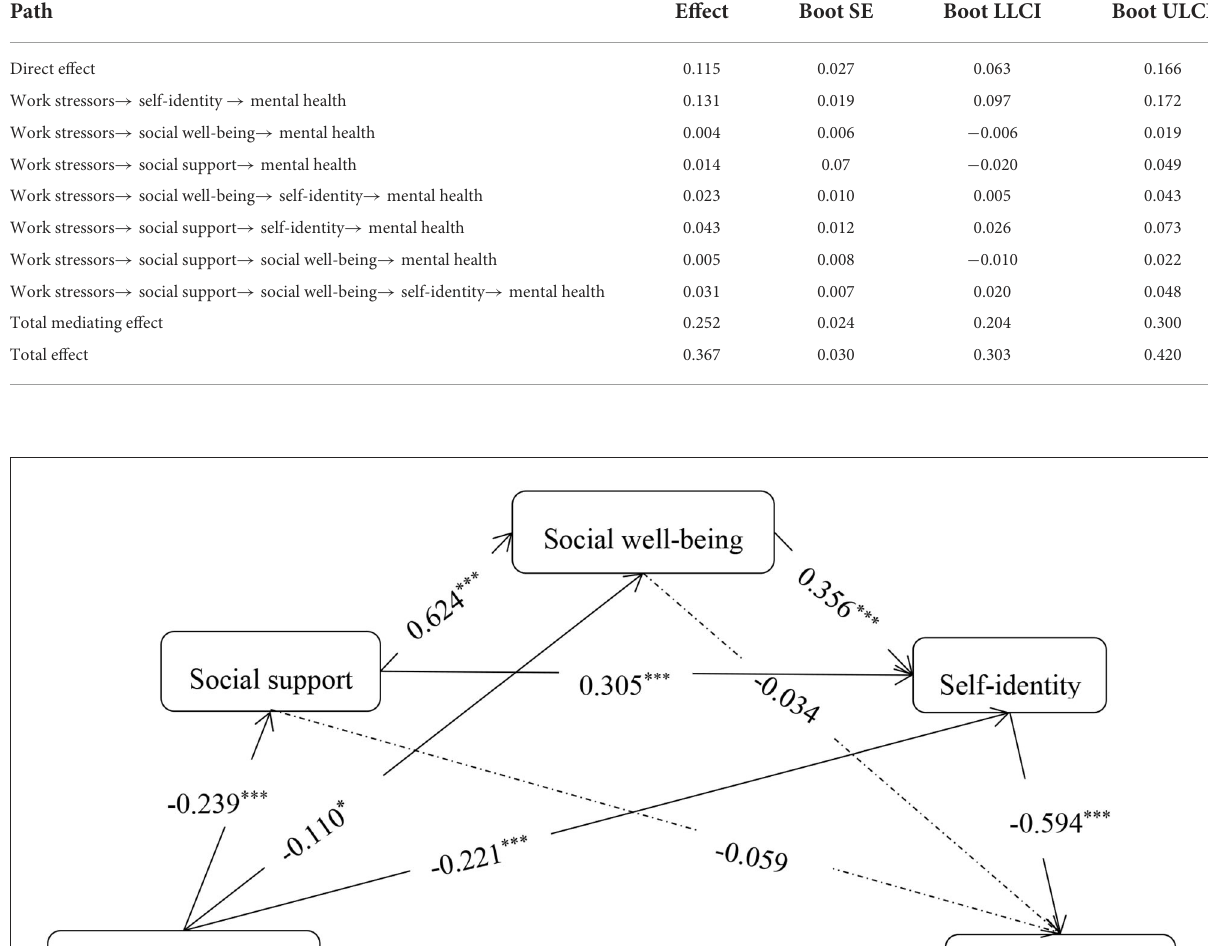
TABLE 6 The chain mediating effect of social support, social well-being and self-identity between work stressors and mental health.